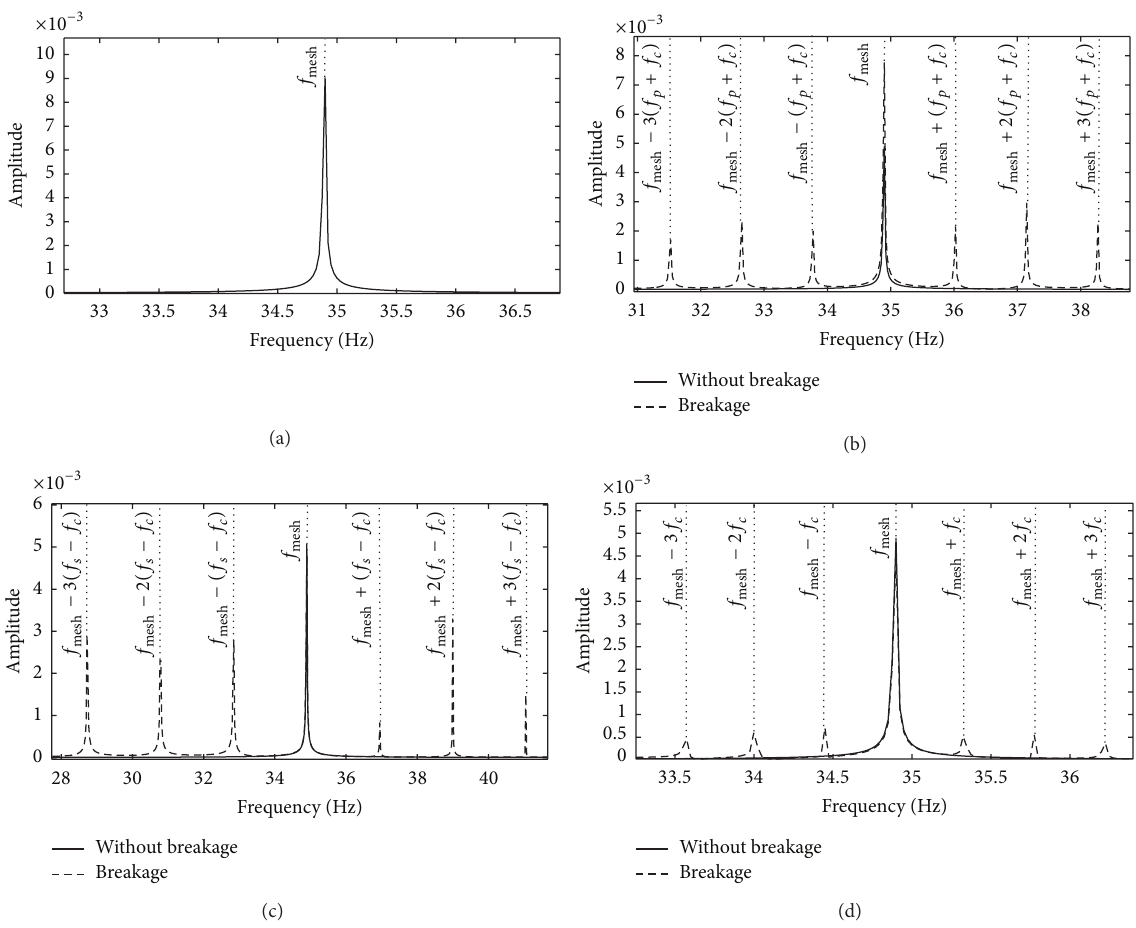
Figure 5: The acceleration spectrum of the ring gear in longitudinal direction in the system with and without tooth breakages (without errors): (a) without breakage, (b) planet gear with and without tooth breakages, (c) sun gear with and without tooth breakages, (d) ring gear with and without tooth